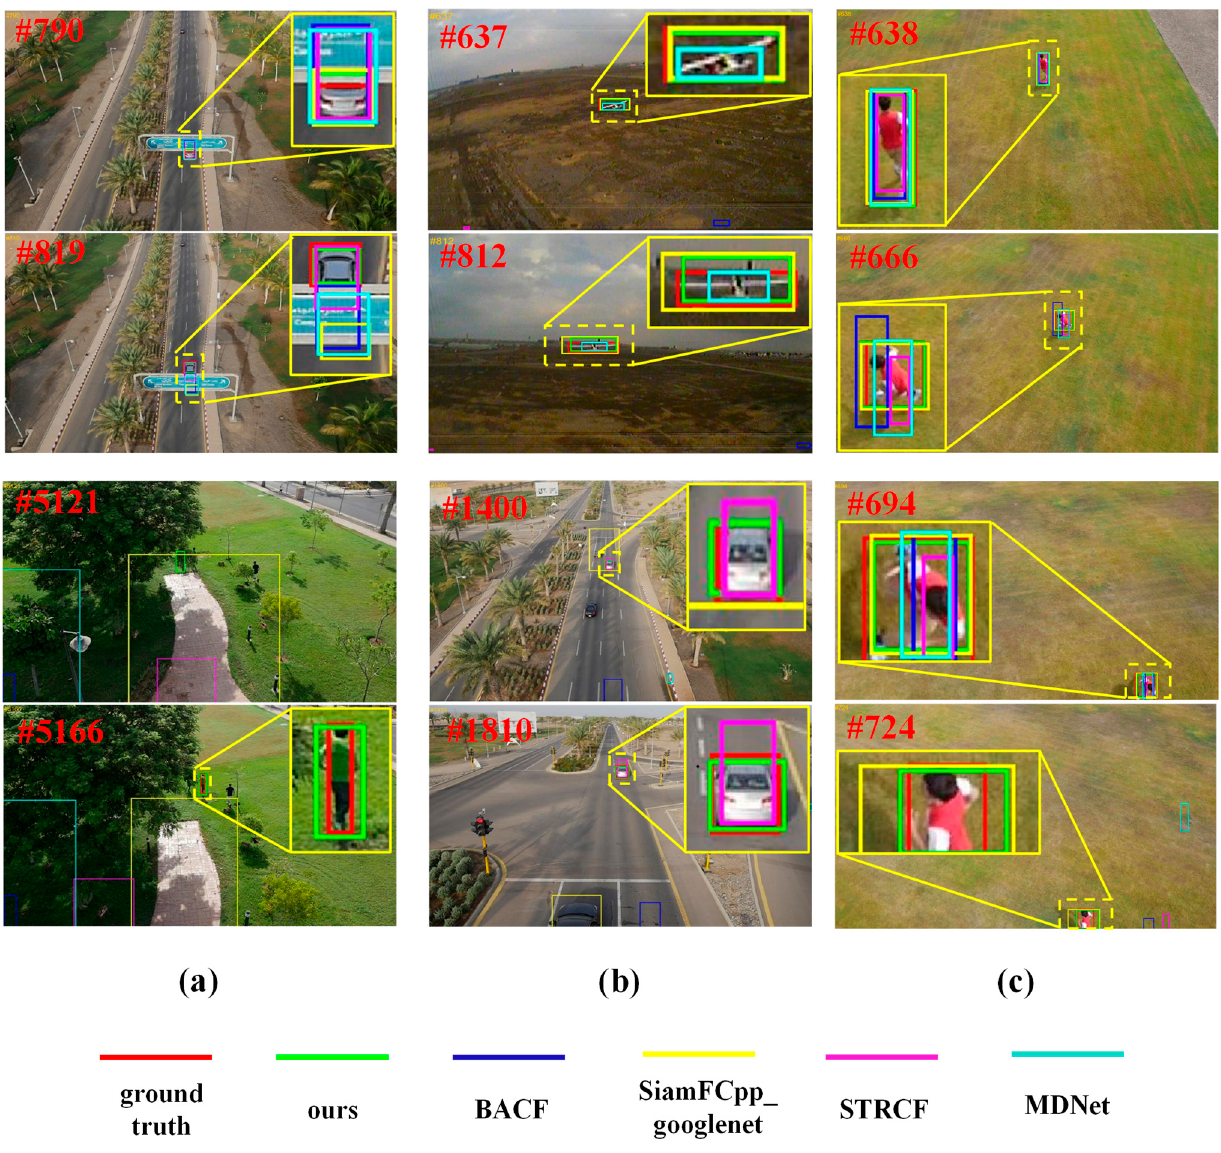
Figure 4. Tracking results of the proposed tracker and other state-of-art trackers on the UAV20L dataset. From top to down and left to right are the screenshots of the tracking results on the videos of car9 , group3 , uav1 , car9 , and person7 respectively. The video sequences in ( a ), ( b ) and ( c ) mainly involve FOC and POC, FM and SV, FM and OV, respectively.